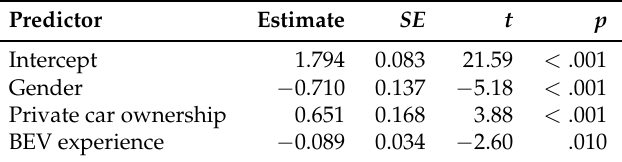
Table 5. Model coefficients for predicting range